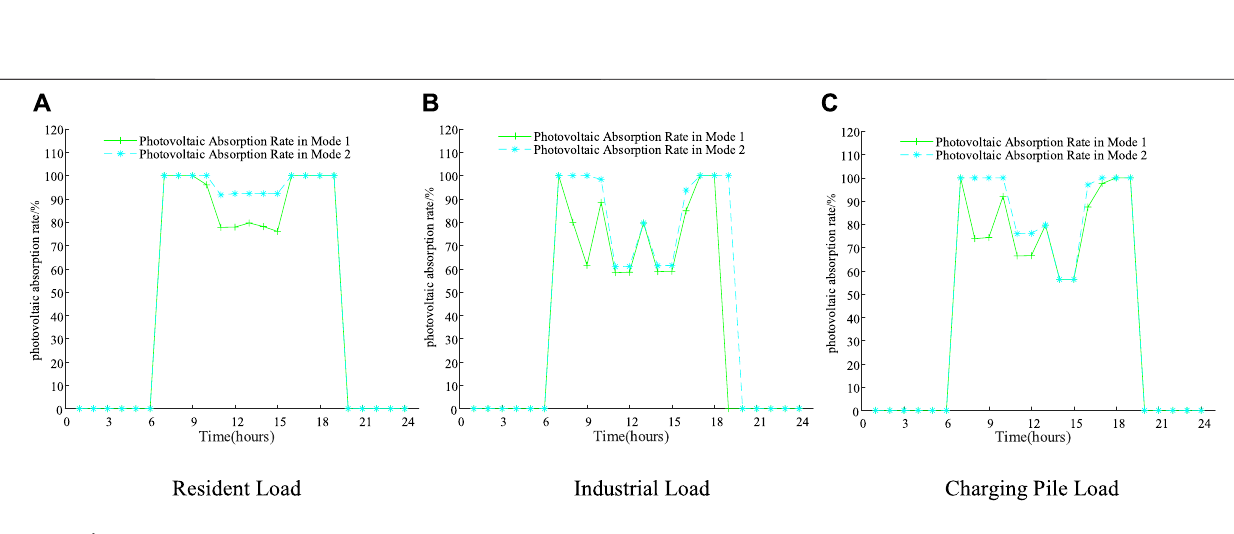
FIGURE 7 | Comparison curves of PV absorption rates in three scenarios under two modes.